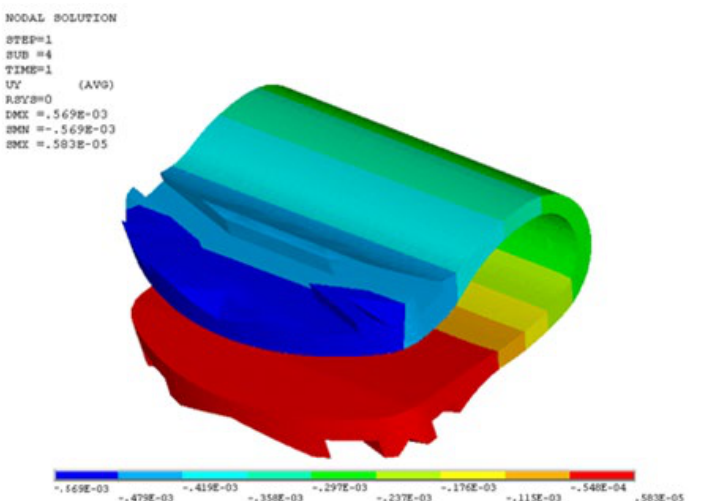
Figure 2. The deformation of pure Ti DCI within human C5–C6 cervical segments under the flexion condition.